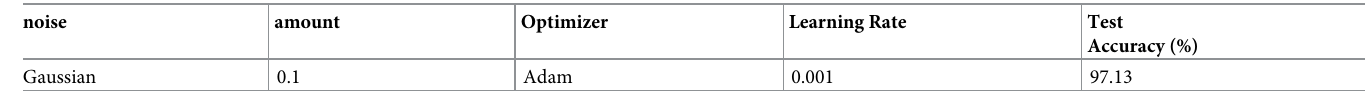
Table 23. Performance of proposed model on noisy dataset.